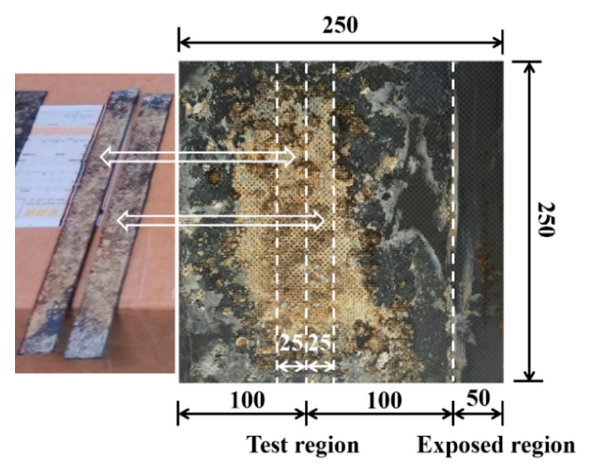
Figure 3. Preparation of the CFRP coupons for the tensile tests after electrochemical (EC) tests (all dimensions are in mm).